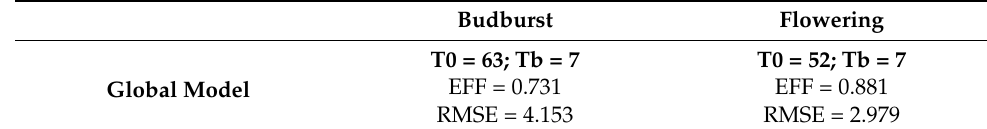
Table 4. Goodness-of-fit indicators of global GDD model for estimation process using the dataset for all grapevine varieties studied. Fitted t0: day of the year and Tb: base temperature.